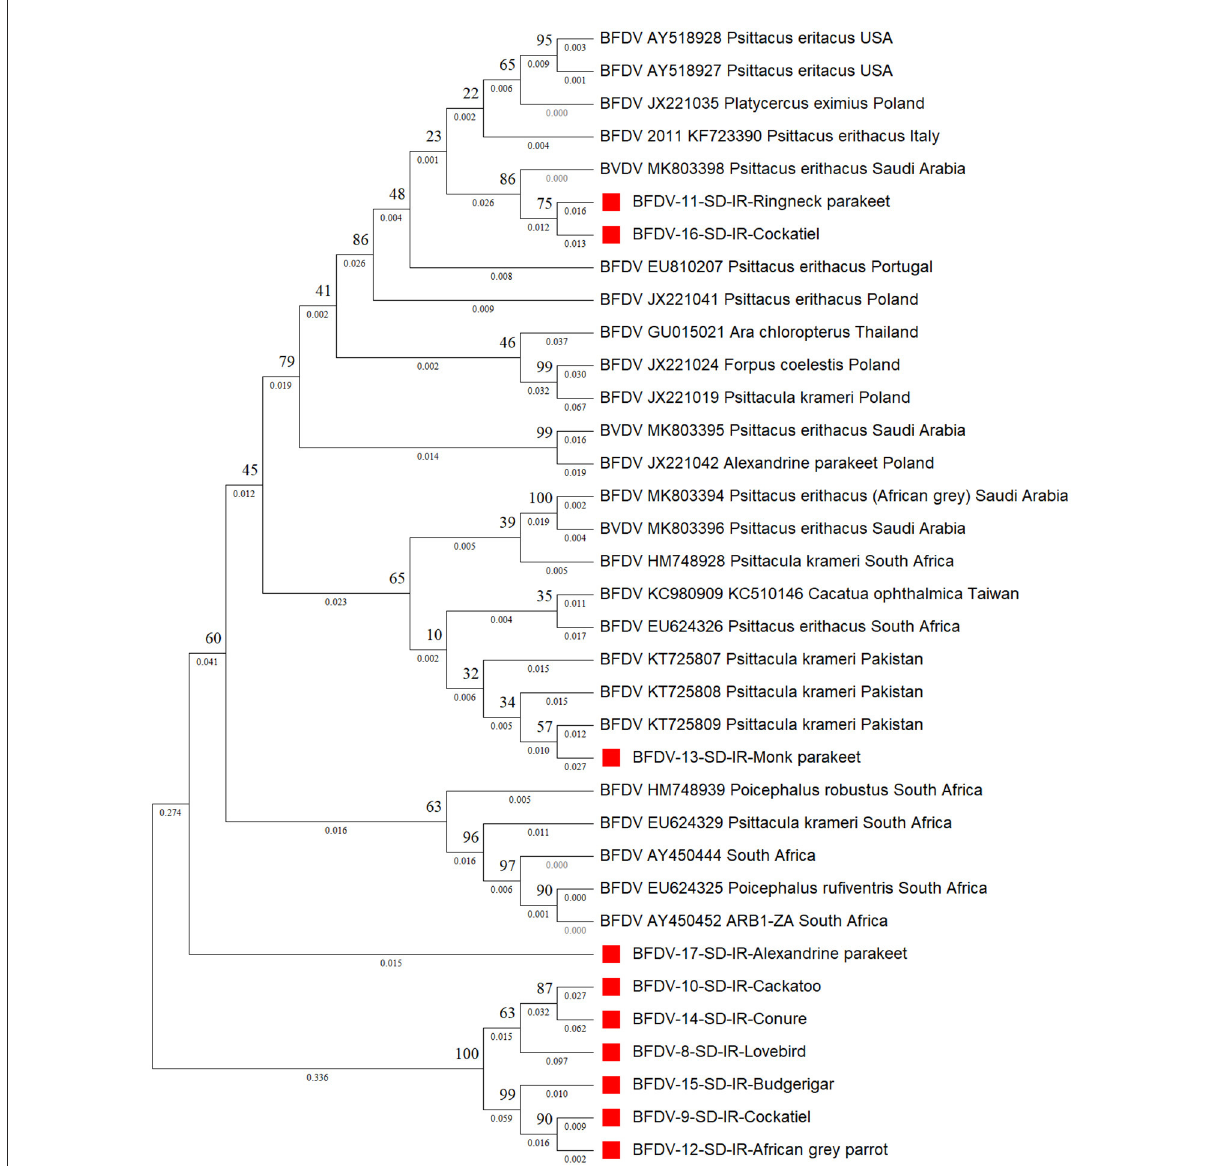
FIGURE4 The neighbor-joining phylogenetic tree constructed on cap sequences using Mega ver. 11 and 1,000 bootstrap replications. This tree illustrates the distance between the infected hosts (OP039985- OP039994) and public BFDV cap sequences from other Psittaciformes available in GenBank. Numbers at nodes represent the frequency of Bayesian posterior probability between two subsequent clusters or strains. Each sequence labeled with BFDV year of specimen collection, GenBank accession numbers, host species, and country. The samples used in this study are marked with a red color cubic ( (cid:4) )